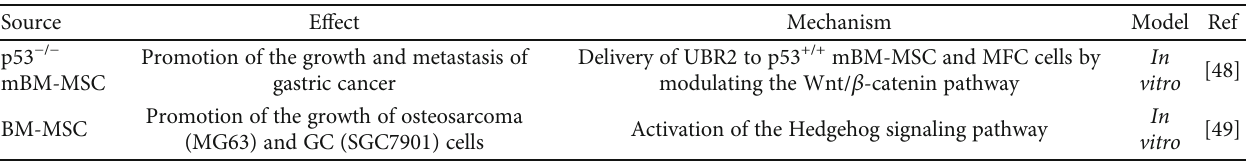
Table 2: E ff ects and mechanisms of MSC-EXs on